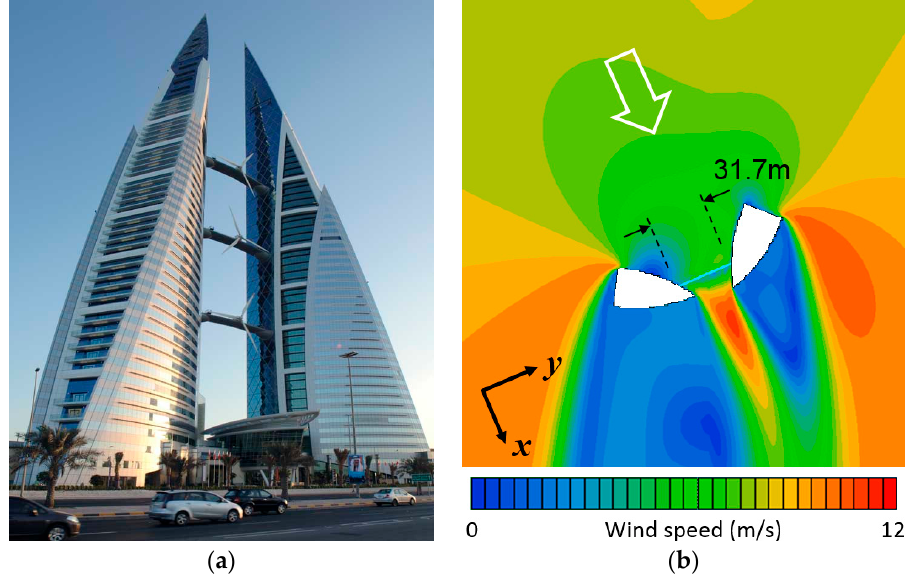
Figure 1. The Bahrain World Trade Center: ( a ) photo from the front of the wind turbines; and ( b ) contour plot of wind speed on a horizontal cross-sectional plane at 100 m aboveground (CFD by the authors).